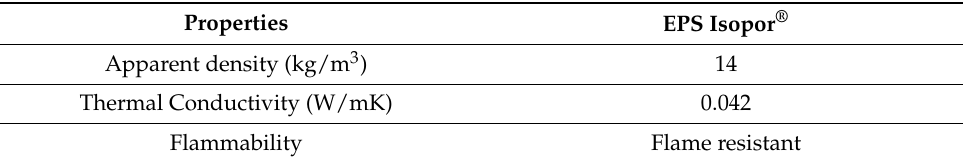
Table 1. Properties of EPS Isopor ® .